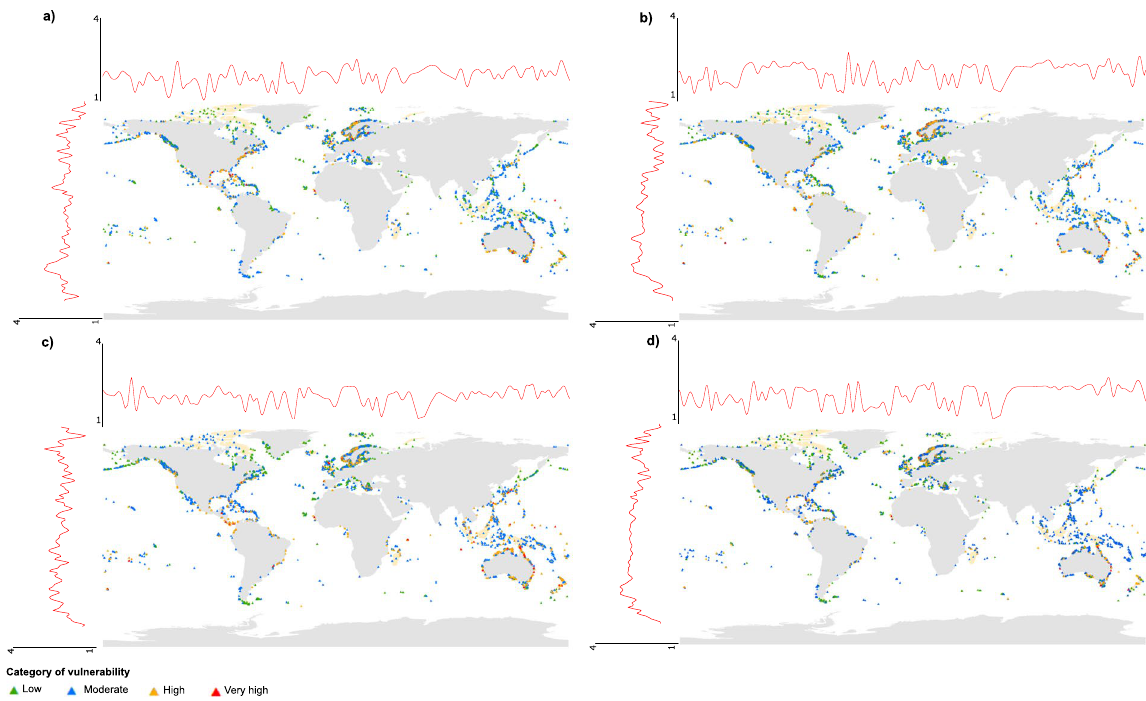
Figure 1. Worldwide distribution of the 5,565 islands with native monocot species and their classification according to four categories of vulnerability (low, moderate, high, very high) to threats related to climate change: ( a ) sea level rise ( b ) shift in temperature, ( c ) shift in rainfall, and ( d ) global vulnerability to climate change. Red lines represent the fitted levels of vulnerability scores (cubic smoothing spline) along longitudes and